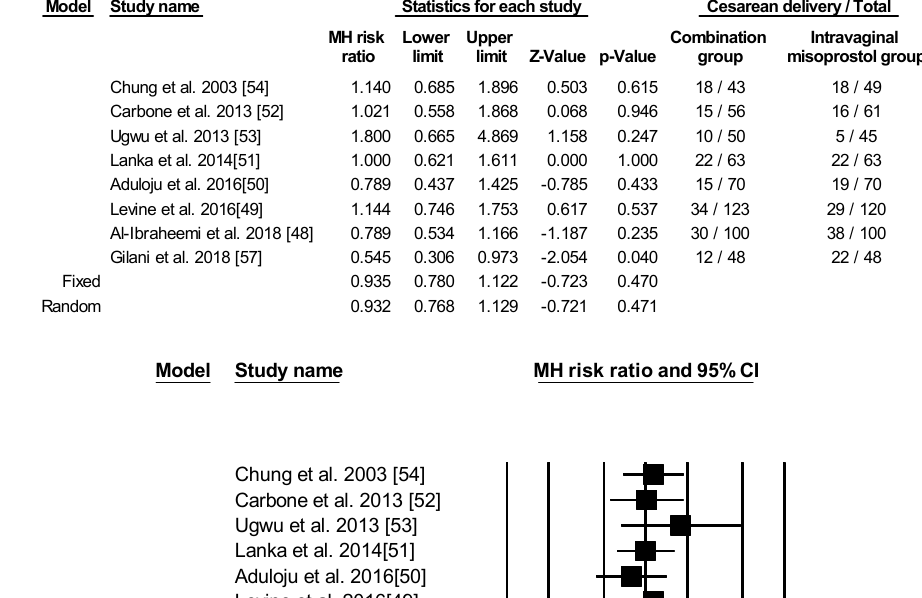
9 of 19 Figure 4. Comparison 3: Combination of intracervical Foley catheter and intravaginal misoprostol versus intravaginal misoprostol alone for cervical ripening, Outcome 3: Time to delivery in sample size < 200. Heterogeneity: Tau 2 = 1.282; ꭓ 2 = 8.907 df = 4 ( p = 0.063); I 2 = 55.093%. Test for overall effect (random): Z = − 2.215 ( p = 0.027)